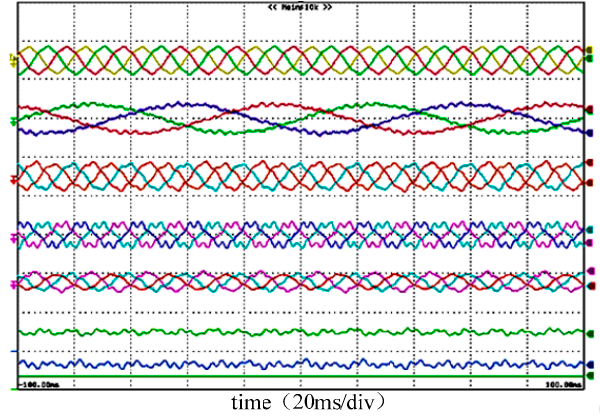
Figure 13. Experimental results of the ISMC for a DFIG system.